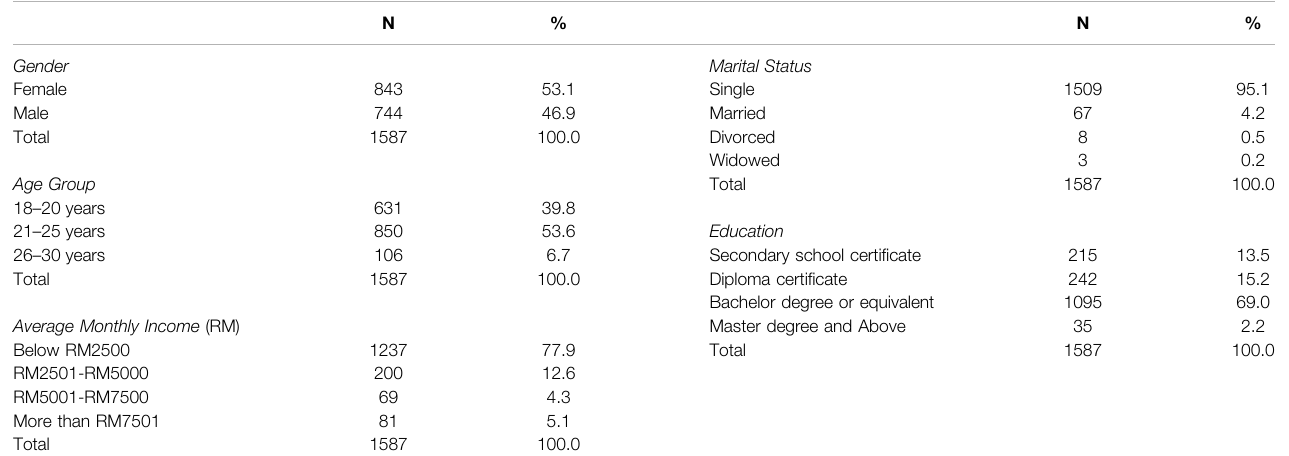
TABLE 1 | Demographic characteristics.